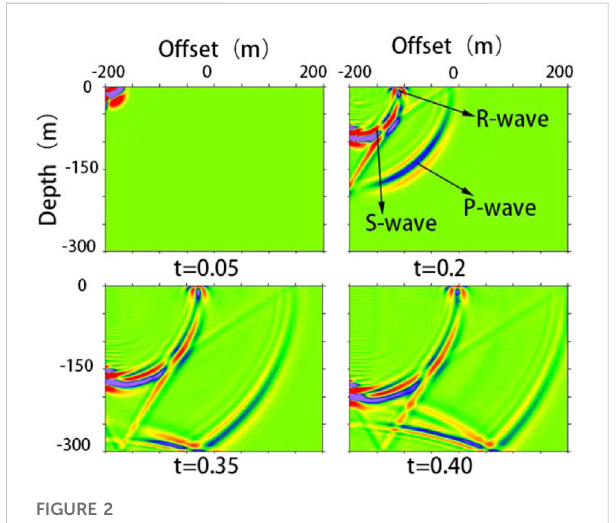
FIGURE 2 Snapshot of vertical pro fi le wave fi eld at different times of homogeneous half-space